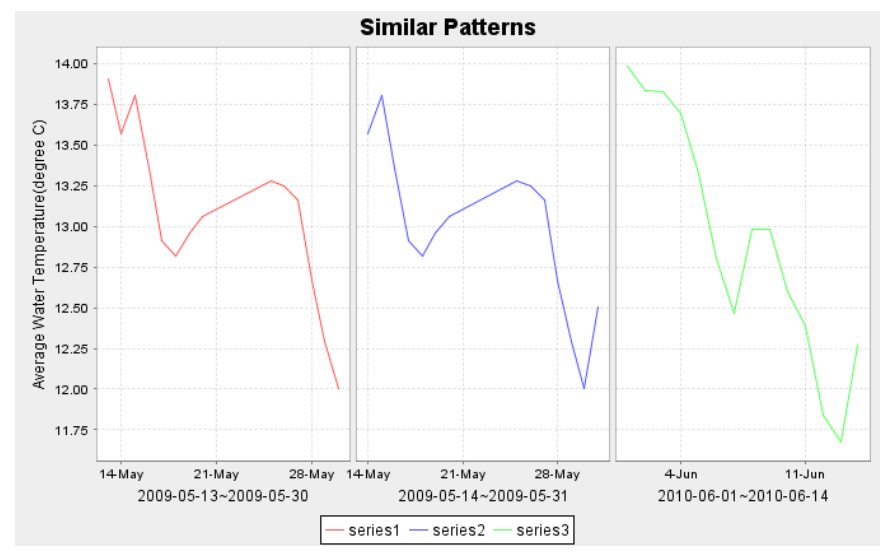
Figure 6. Pattern